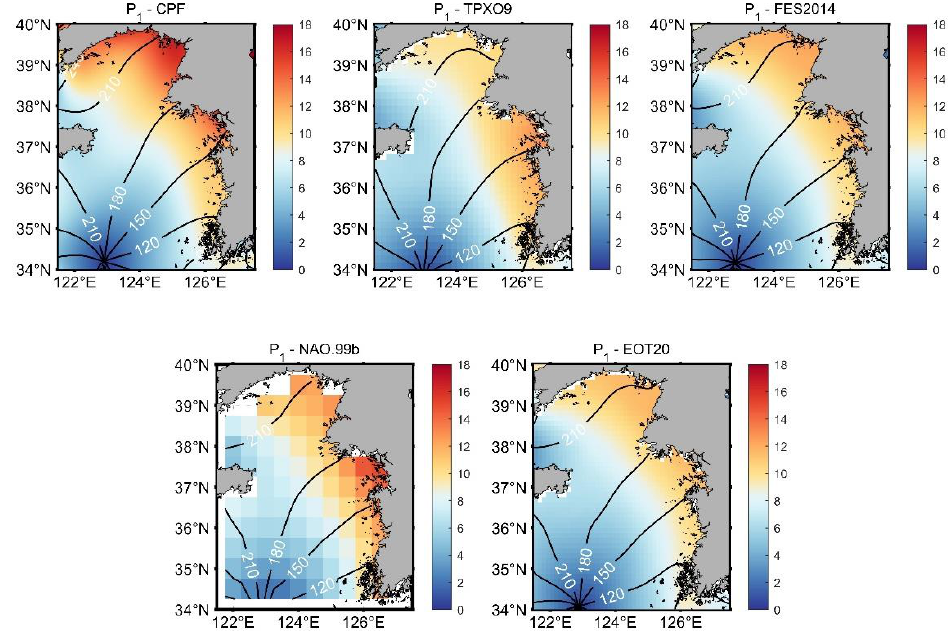
Figure 11. The cotidal charts of the P 1 constituent from the CPF and the TPXO9, FES2014, NAO.99b and EOT20 models (unit: cm).